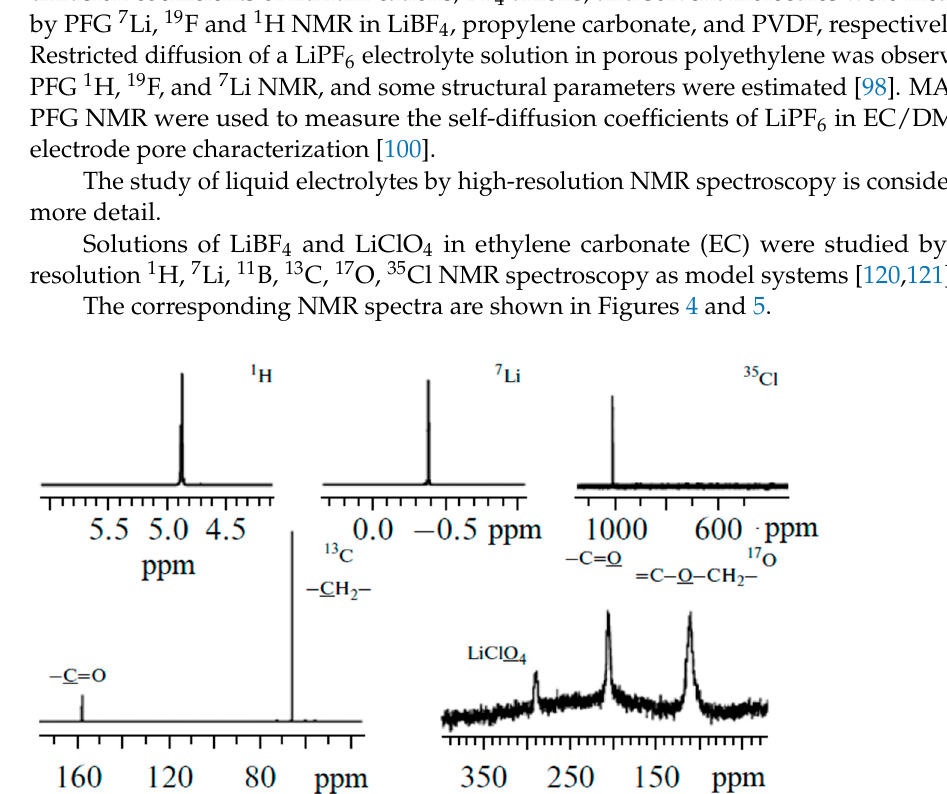
Figure 5. Experimental 1 H, 7 Li, 19 F, 13 C, 17 O, and 11 B NMR spectra of a 0.66 molality solution of LiBF 4 in ethylene carbonate [121].